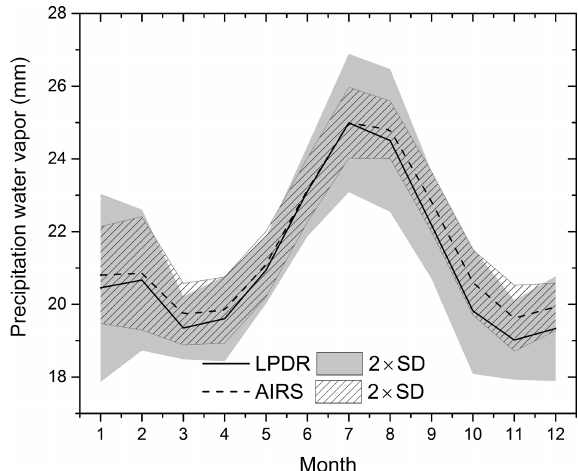
Figure 5. LPDR and AIRS PWV monthly means and seasonal vari- ability (2 times the standard deviation or 2 × SD) over the globe